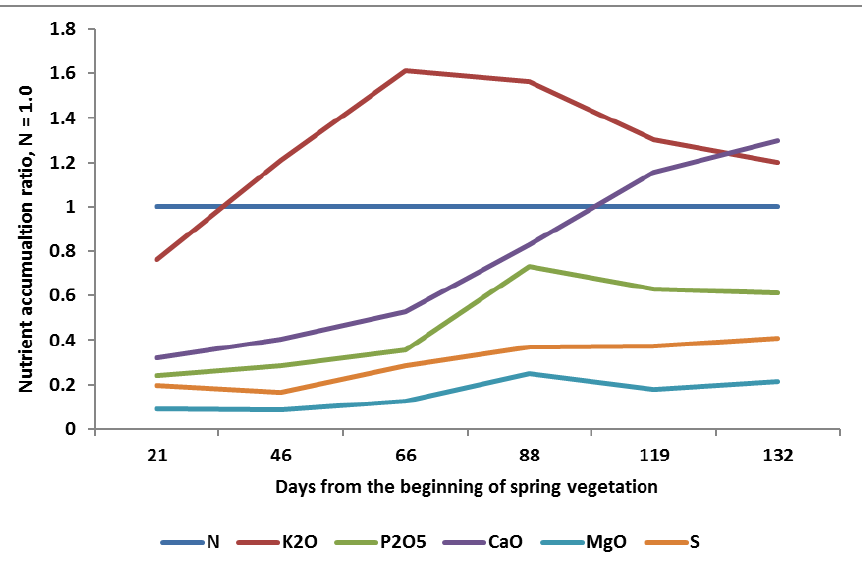
Figure 3. Patterns of nutrient accumulation during the growing season by high-yielding winter oilseed rape (simulation based on [70]).